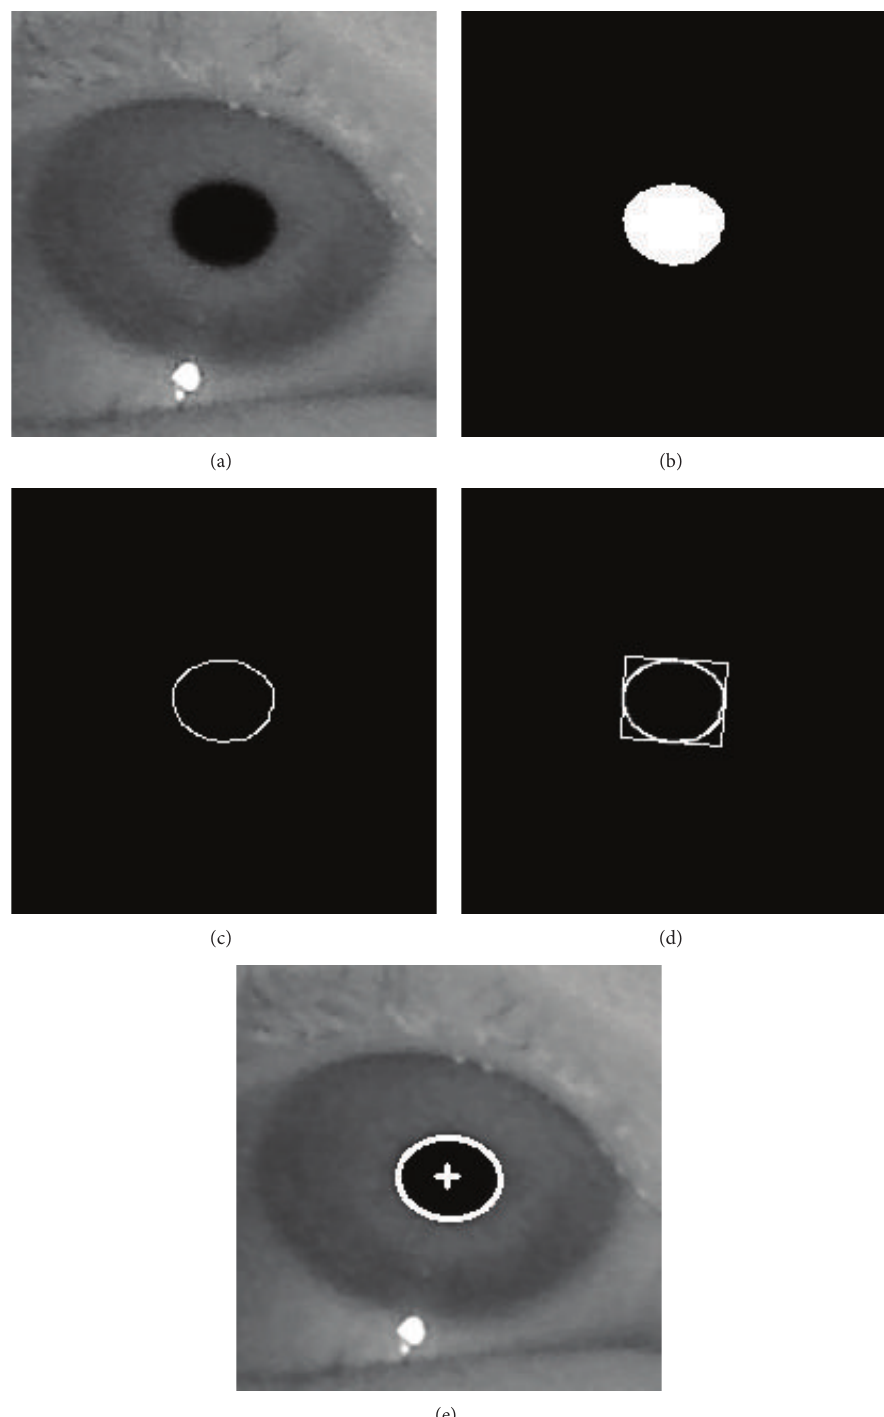
Figure 8: The procedure of accurately detecting pupil centers. (a) Original image. (b) Binarization image of (a). (c) Canny edge detection image of (b). (d) Ellipse fitting image of (c). (e) Image of detected pupil